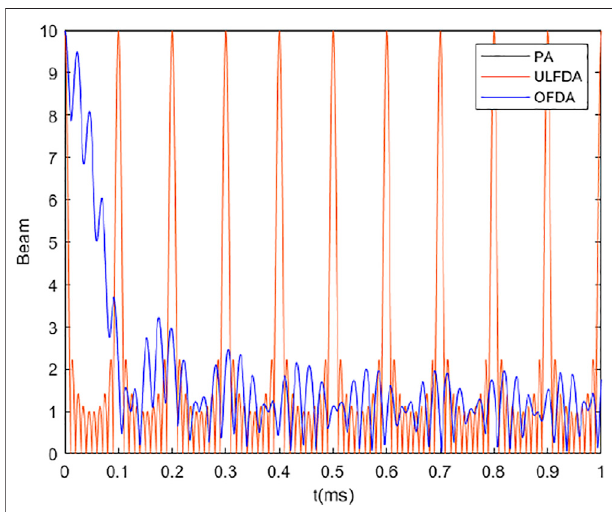
FIGURE 10 | The beam pattern of three array